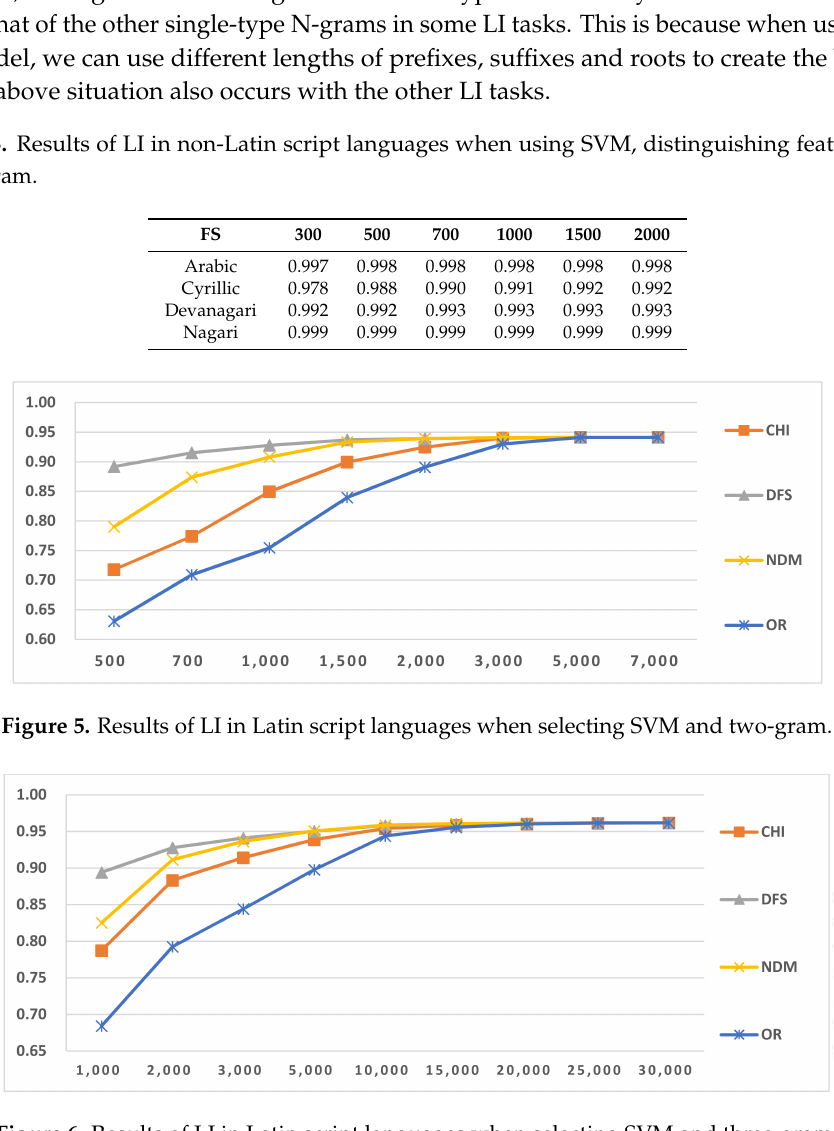
Figure 6. Results of LI in Latin script languages when selecting SVM and three-gram.